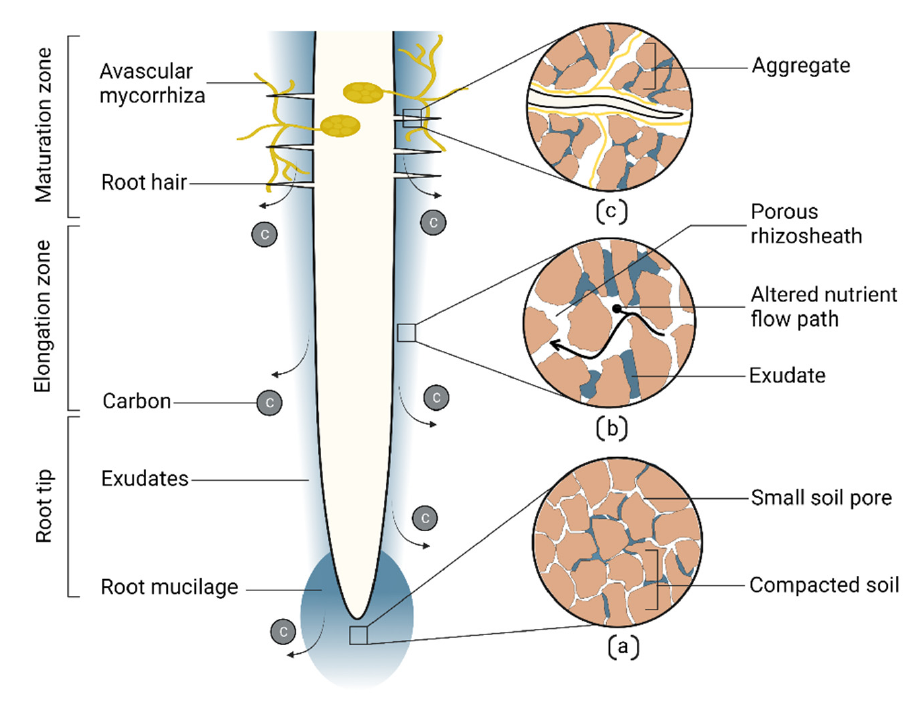
Figure 5. Root soil building attributes. Root exudation releases carbon into the soil. ( a ) Soil compaction and reduction of pore space in the root tip area. ( b ) Formation of porous rhizosheath area and altered nutrient flow path due to root mucilage. ( c ) Soil aggregation by root mucilage, root hair, and avascular mycorrhiza hyphae.